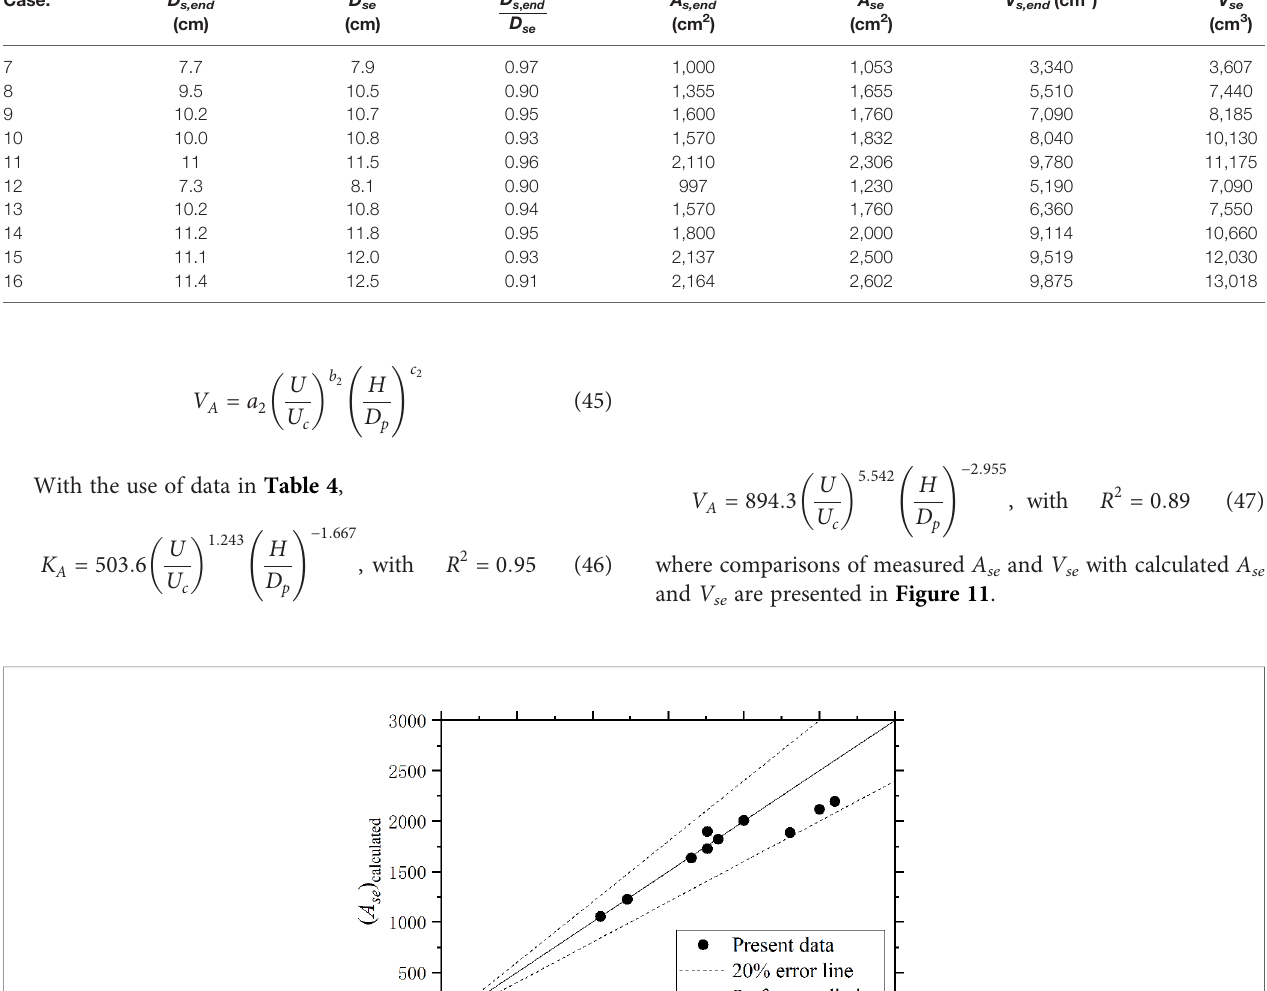
TABLE 4 | Calculated scour area and scour volume of the present experiments.